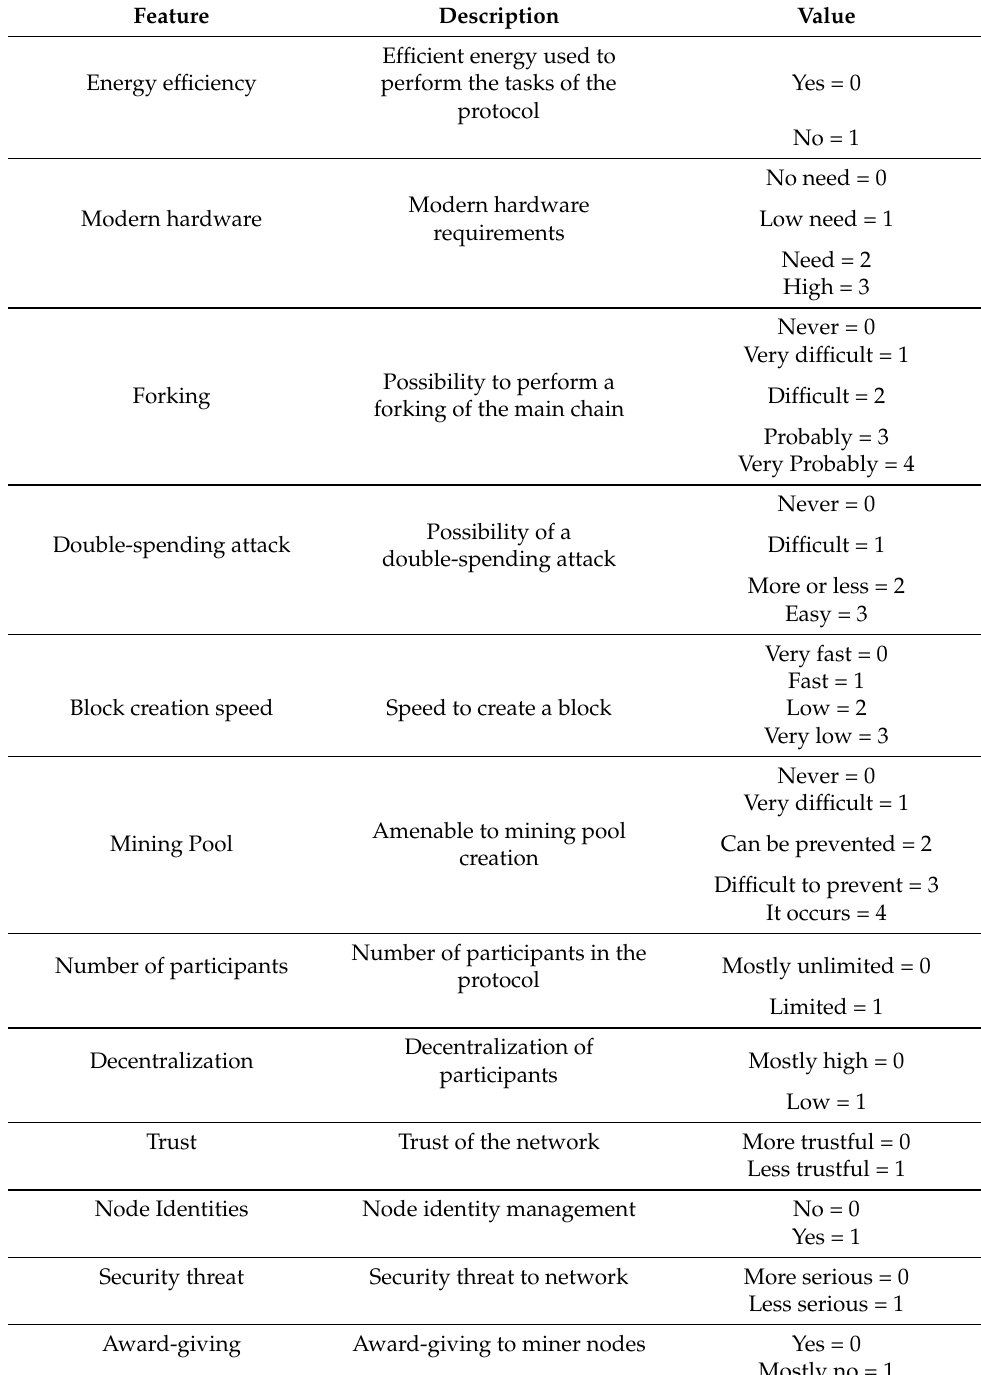
Table 2. Features and values used to